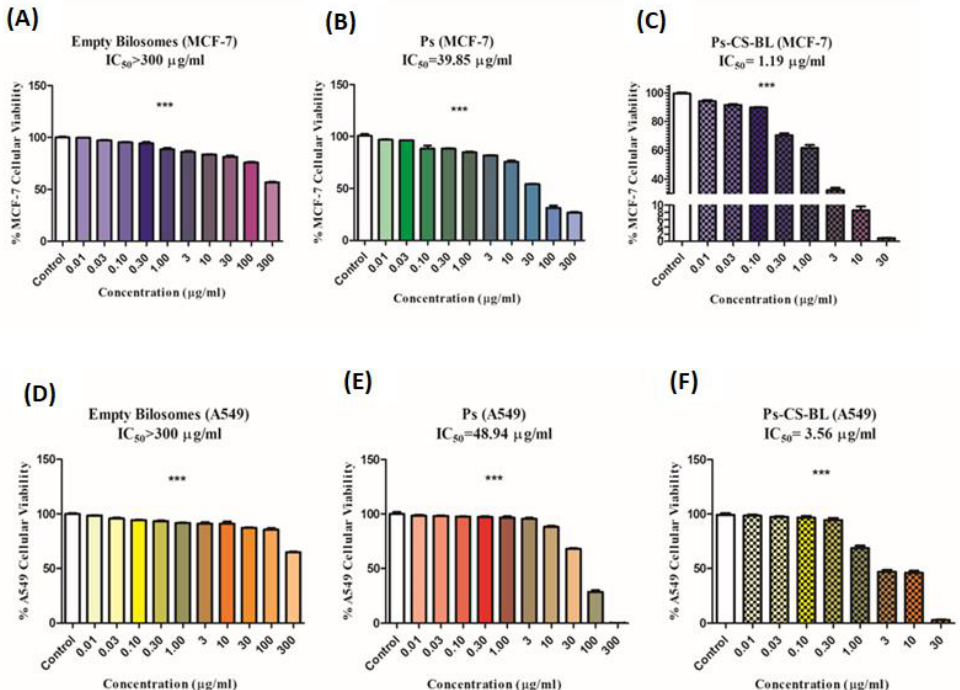
Figure 7. Evaluating the cytotoxicity of ( A ) empty bilosomes, ( B ) Ps/BLs, and ( C ) Ps-CS/BLs in MCF-7 cells, and ( D ) empty bilosomes, ( E ) Ps/BLs, and ( F ) Ps-CS/BLs in A549 cells using SRB assay, at several concentrations ranging from 0.01 to 300 µg/mL. An overall statistically significant decrease in cell viability was detected with Ps-CS/BLs as compared to free Ps in both cancer cells ( p < 0.05). Untreated cells were utilized as negative control (considered as 100%). (*** p < 0.05 compared with the control group).